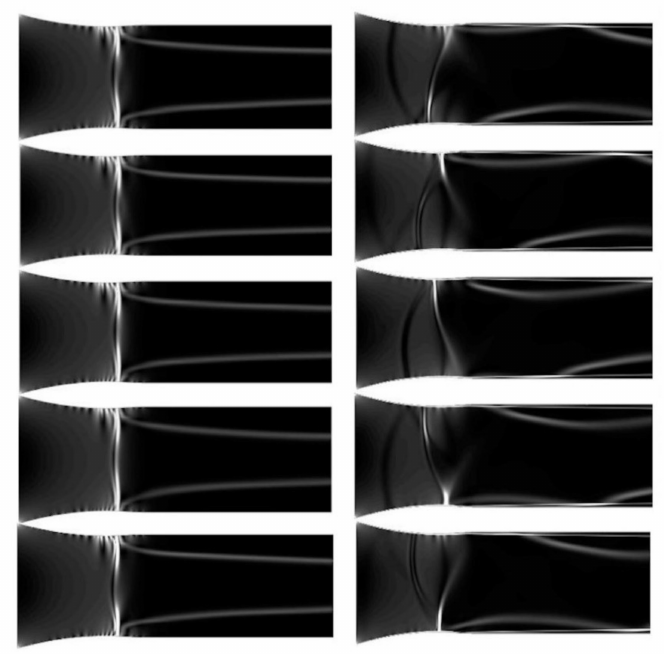
Figure 7. One oscillation cycle in a parallel nozzle for inviscid flow model with air relative humidity equal to 51.6% (left, ~ ∆ t = 10 − 3 s) and 82% (right, ~ ∆ t = 20 − 4